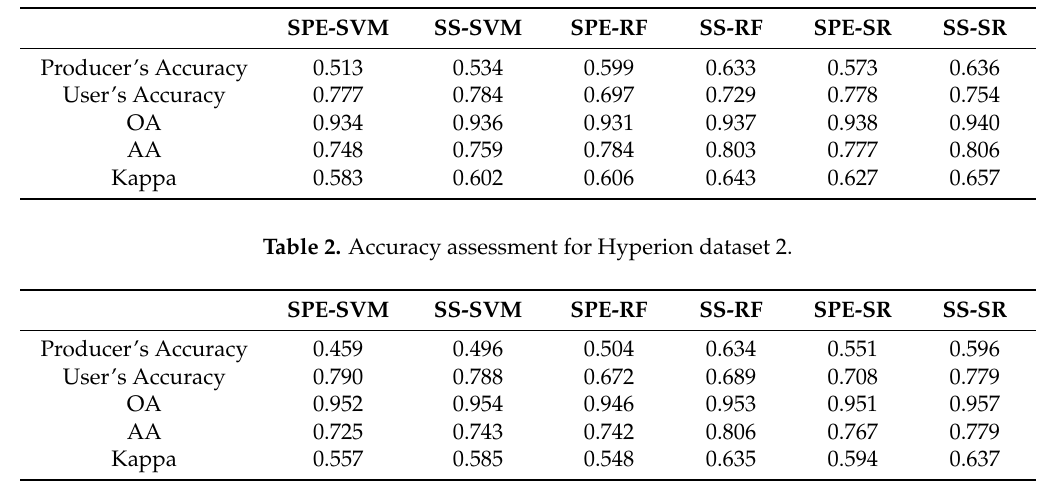
Table 1. Accuracy assessment for Hyperion dataset 1.